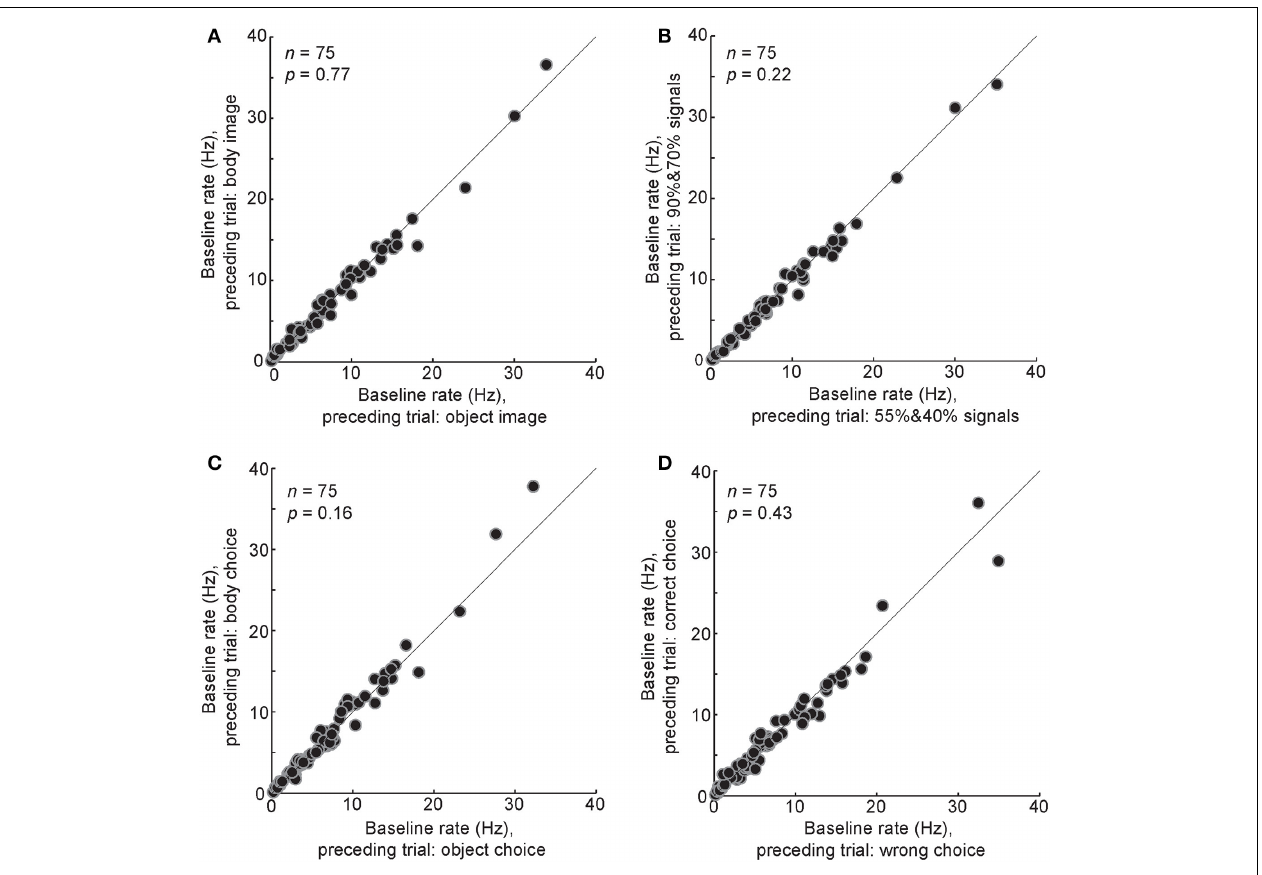
FIGURE 7 | Relationship between different events in the preceding trial and the baseline airing rate in the following trial. The baseline firing rates were compared between different conditions of the last trial: a body or a non-body image was presented (A) , a high-noise (90 and